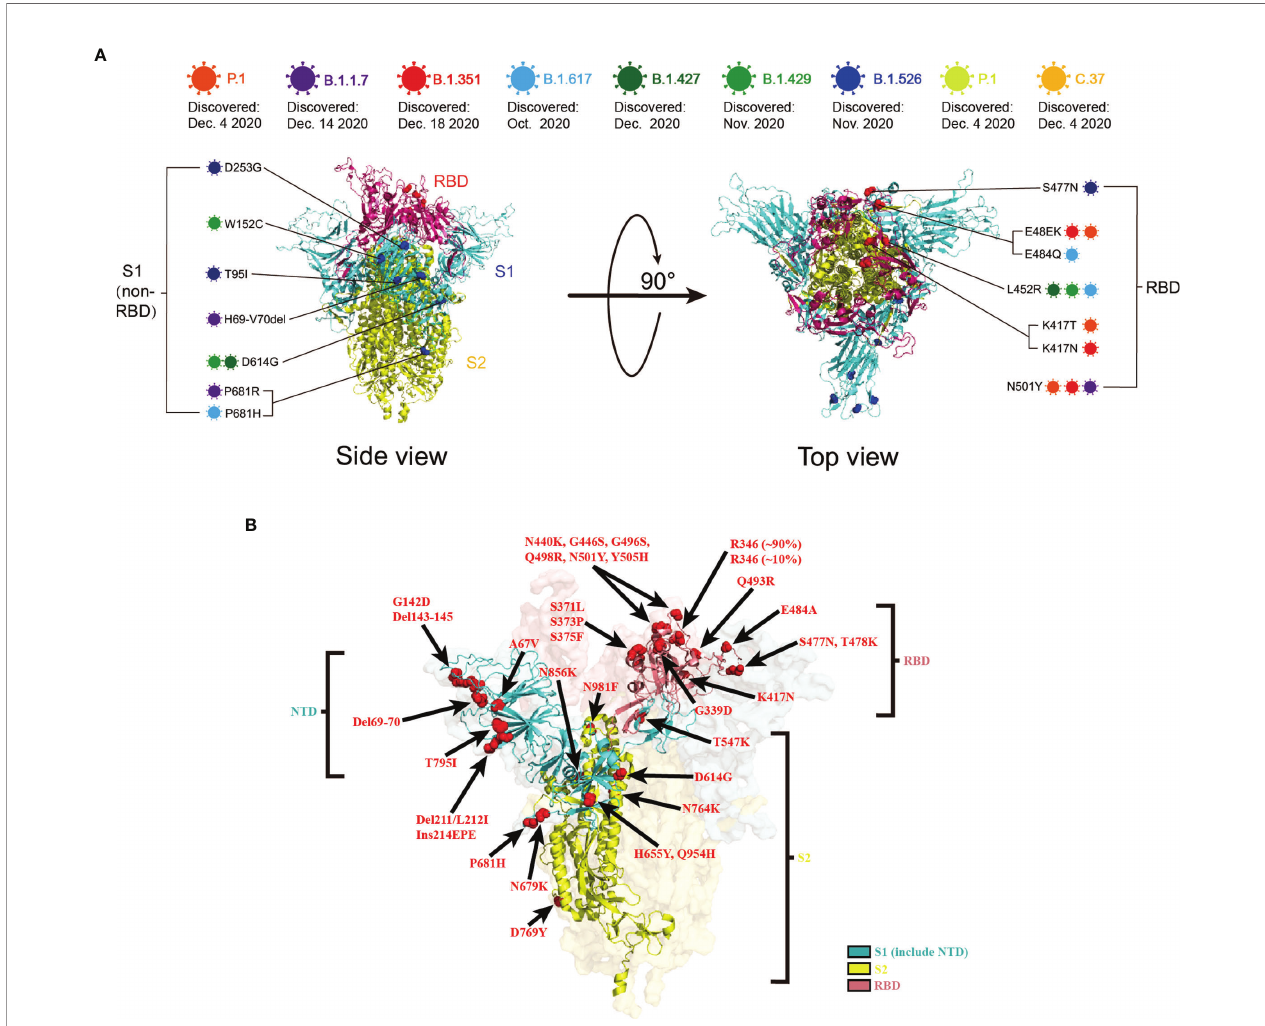
FIGURE 3 | (A) Schematic representation of the mutation sites on various mutant viruses. Schematic diagram of the SARS-CoV-2 spike protein structure and the mutation sites of the mutant strains in this review: B.1.1.7 (Purple), B.1.351 (red), P.1 (orange), B.1.617 (blue), B.1.427 (dark green), B.1.429 (light green), B.1.526 (dark blue), AY.1 (yellow), C.37 (light orange). (B) Mutations within B.1.1.529 denoted on the full SARS-CoV-2 spike trimer. The SARS-CoV-2 spike structure was downloaded from PDB